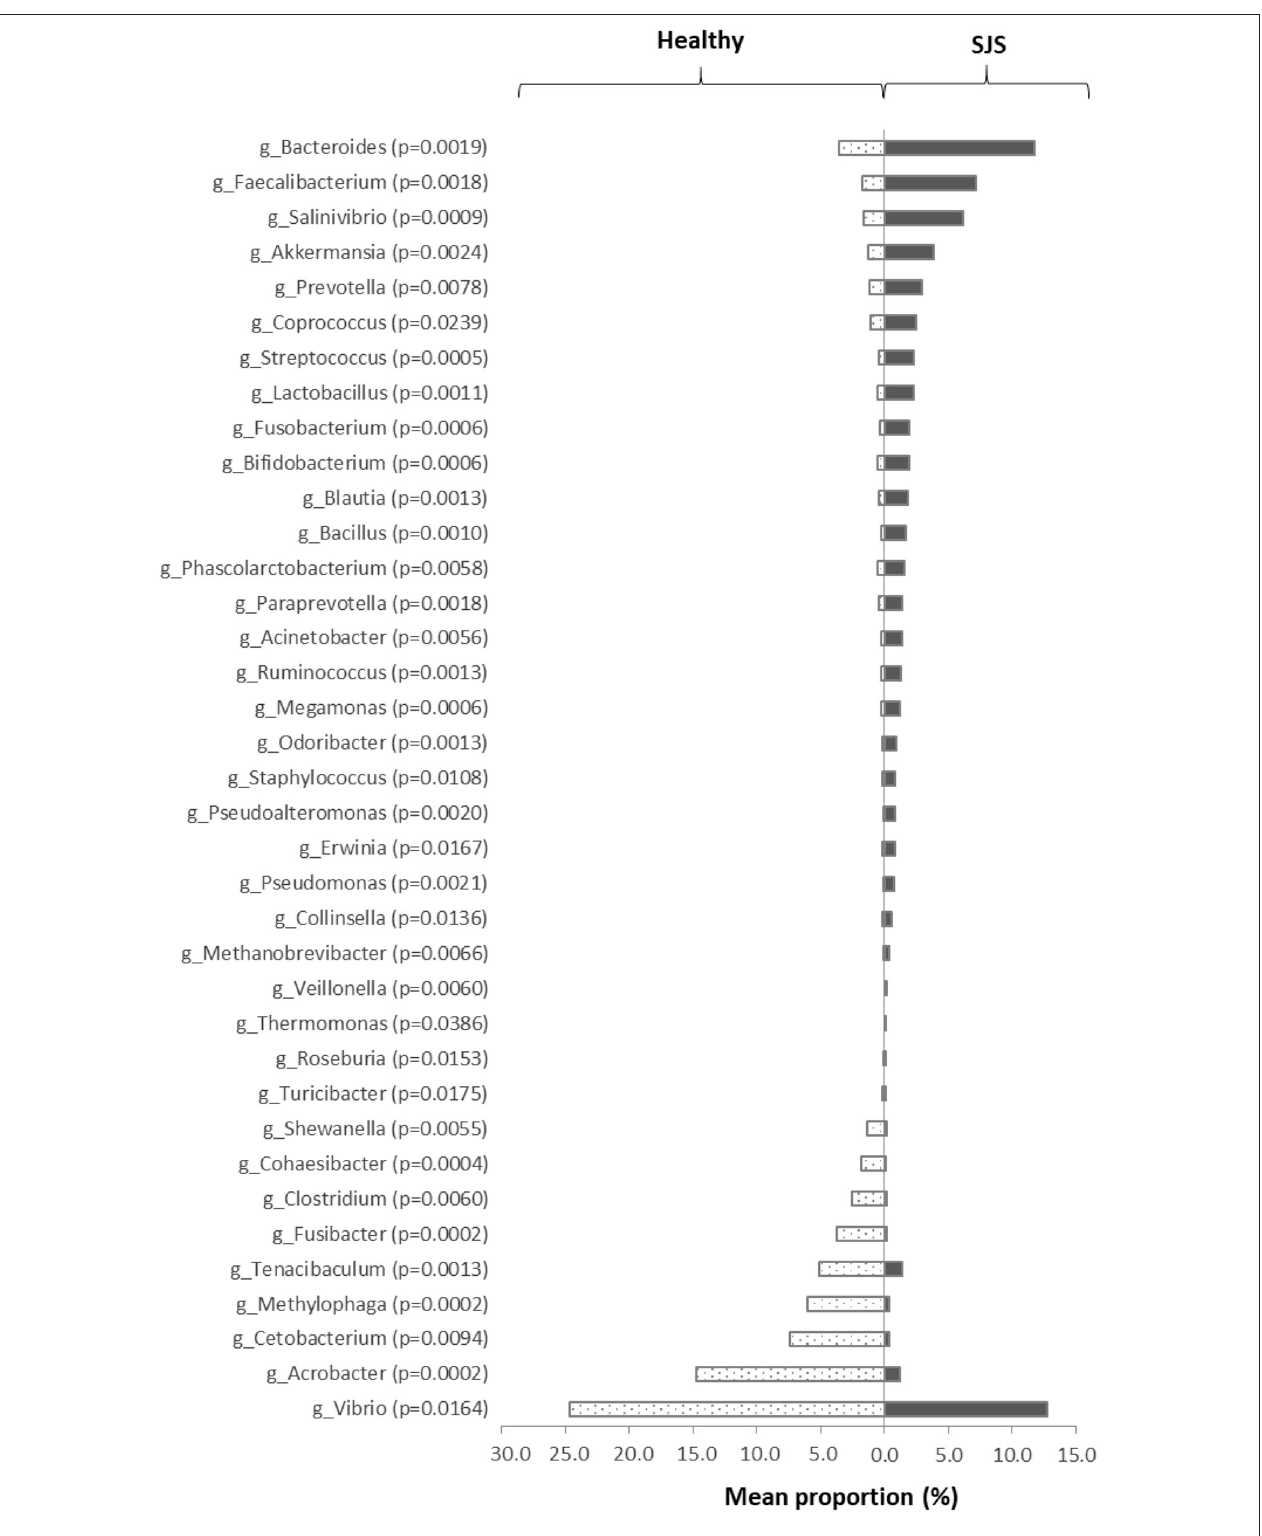
FIGURE 1 | The significant difference in taxa abundance. This figure represents the significant difference in each genus’ taxonomic level compared between SJS patients and healthy subjects. We analyzed the proportion of each genus by Mann–Whitney U -test. The p < 0.05 was defined as statistically significant difference.